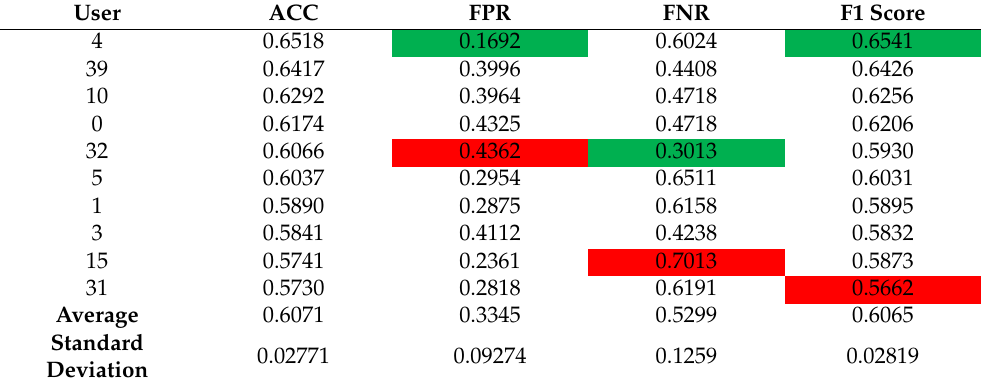
Table 4. SVM results.